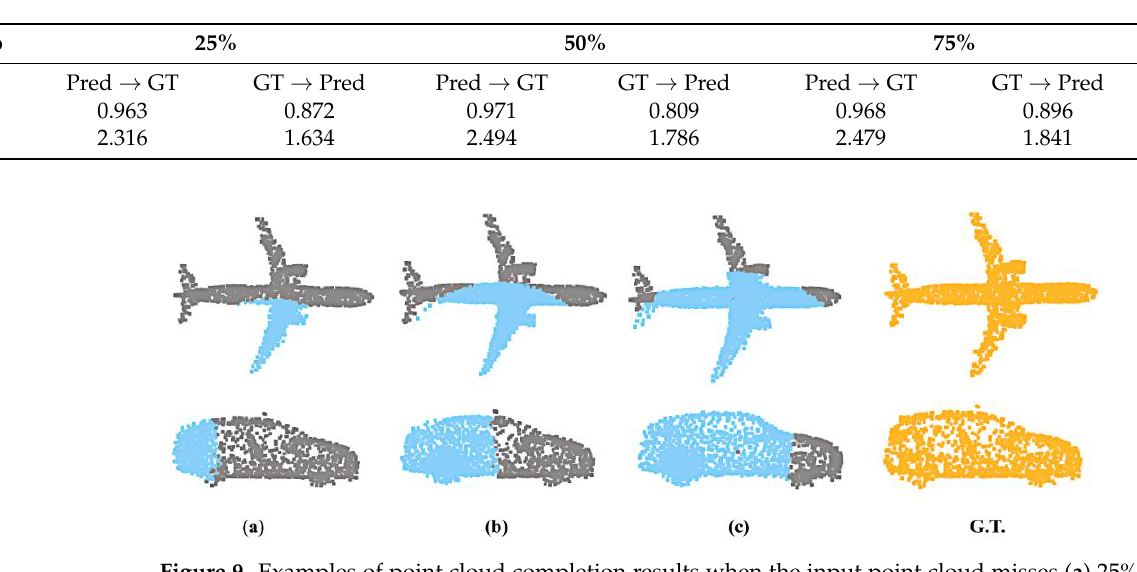
Figure 9. Examples of point cloud completion results when the input point cloud misses (a) 25%, (b) 50%, and (c) 75% of the original point cloud. Gray and blue denote the input incomplete point cloud and predicted missing point cloud, respectively. Yellow represents the real point cloud.